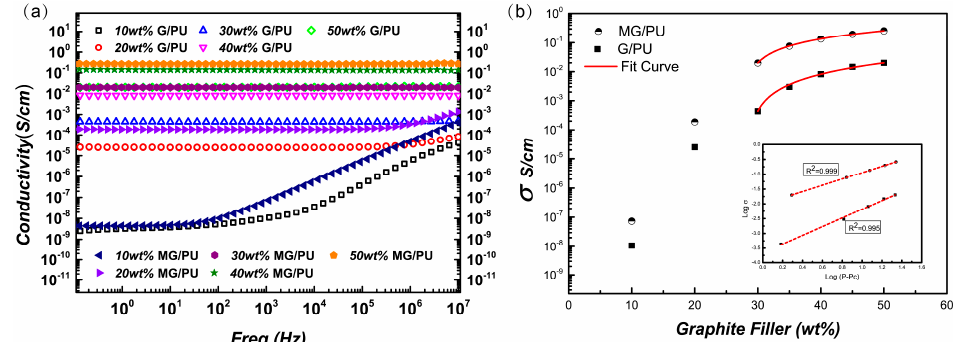
Figure 7. ( a ) Frequency dependence of the conductivity at room temperature for G/PU and MG/PU films with different filler weight fractions (wt %); ( b ) Dependence of the conductivity on the modified graphite weight fraction P. The curves are the fits to the percolation theory.